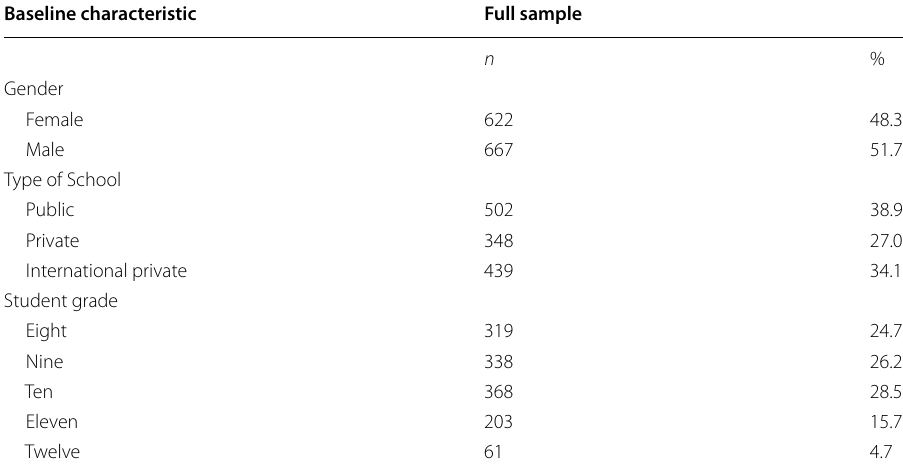
Table 2 Sociodemographic characteristics of participants Baseline